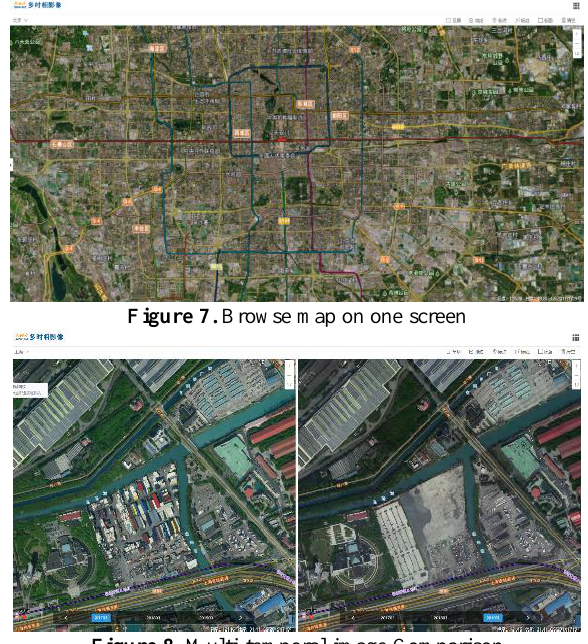
Figure 8. Multi-temporal image Comparison